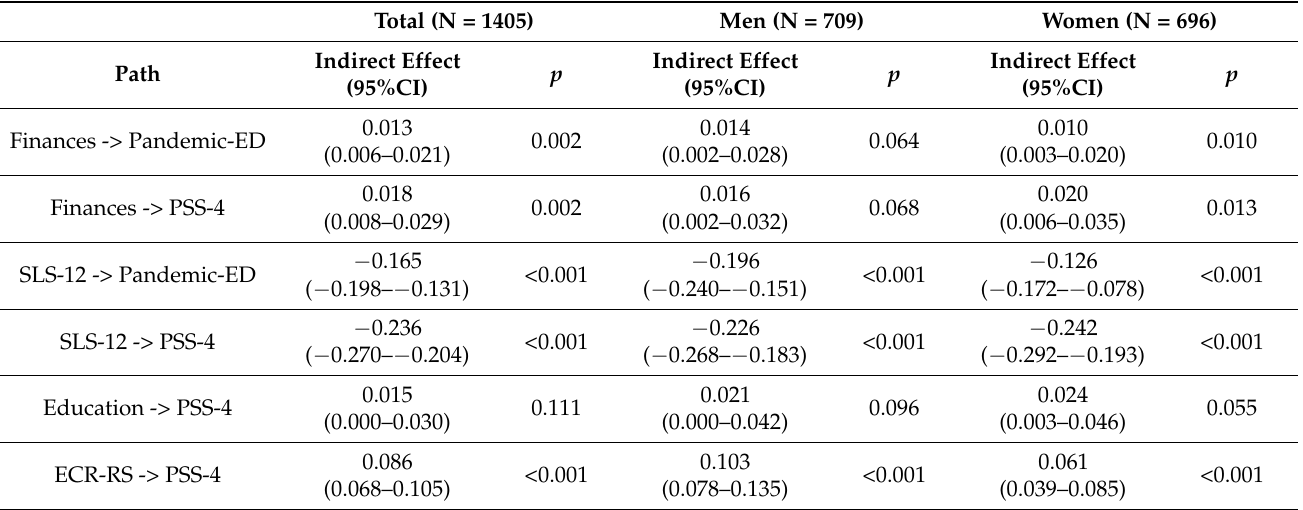
Table 9. Standardized indirect effects with 95% confidence intervals (CIs) (bootstrap sample = 5000). Total (N = 1405) Men (N =